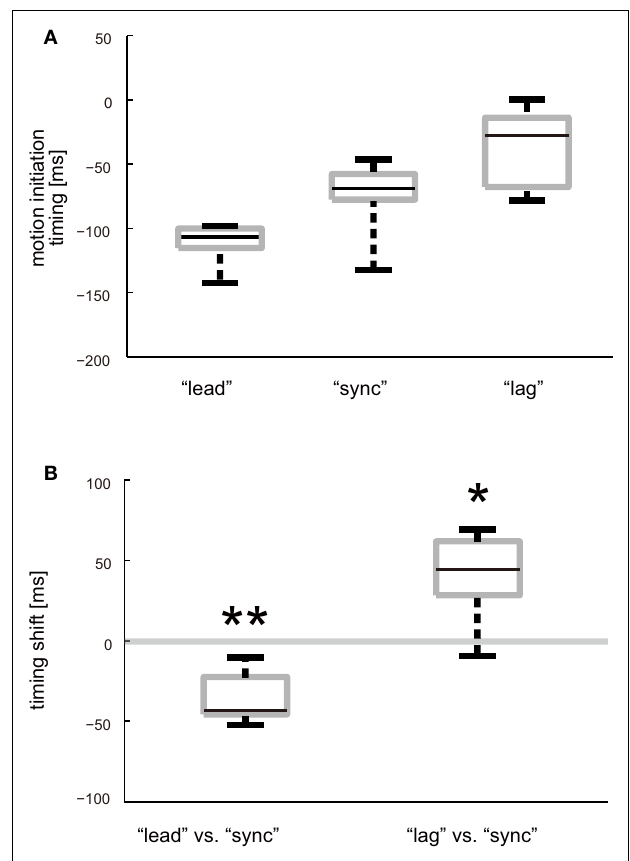
FIGURE 4 |Timing of ball-catching motion initiation. (A) Box plots of average motion initiation timing after “lead,” “sync,” and “lag” conditioning. Average motion initiation timing was calculated for each participant and each experiment. (B) Box plots of shifts in average motion initiation timing after different types of offset conditioning. Amount of shift for each participant was calculated by subtracting average motion initiation timing in theWeight PerceptionTest session of Experiment 1 (after “sync” conditioning) from those of Experiment 2 (after “lead” conditioning) and 3 (after “lag” conditioning). Asterisks denote that the timing shift was significantly greater or less than zero: * P < 0.05, ** P <